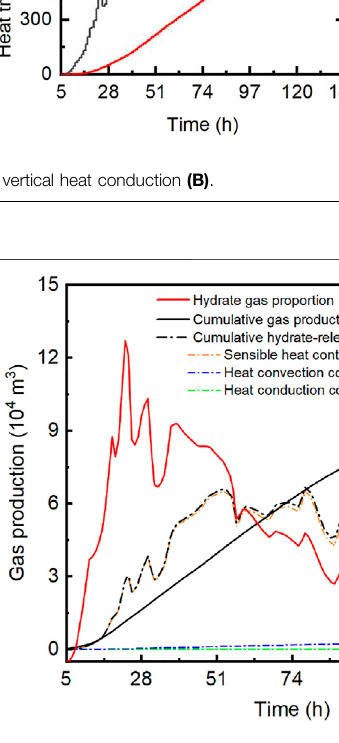
FIGURE 6 | Cumulative sensible heat by the end of each temporal interval, with upper and lower bounds.